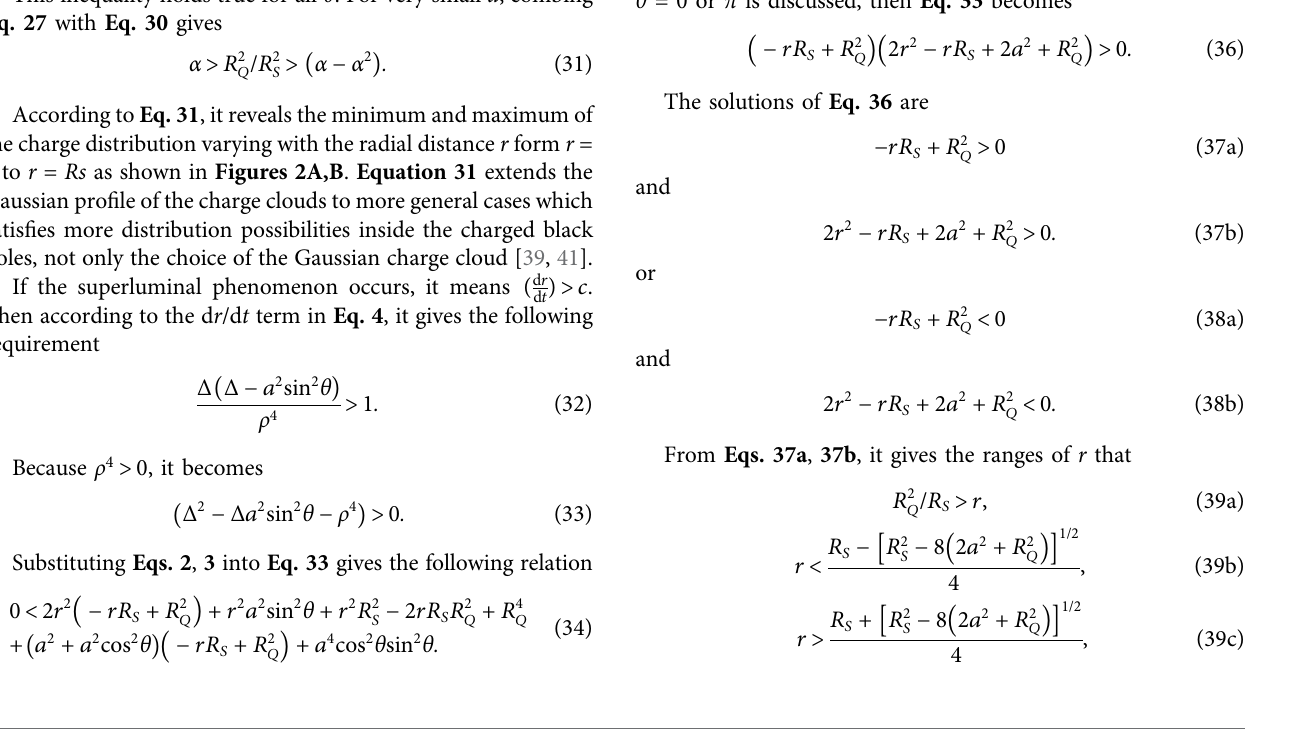
Frontiers in Physics |